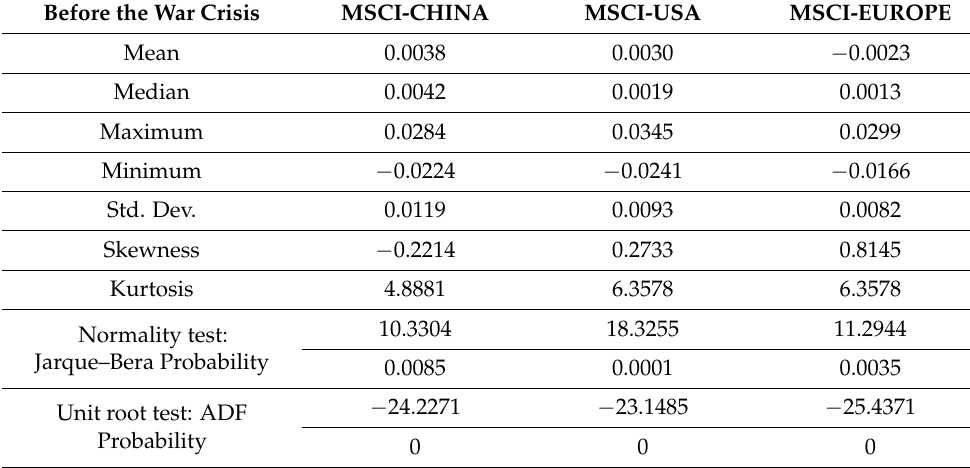
Table 2. Descriptive statistics and stationarity results (before the war